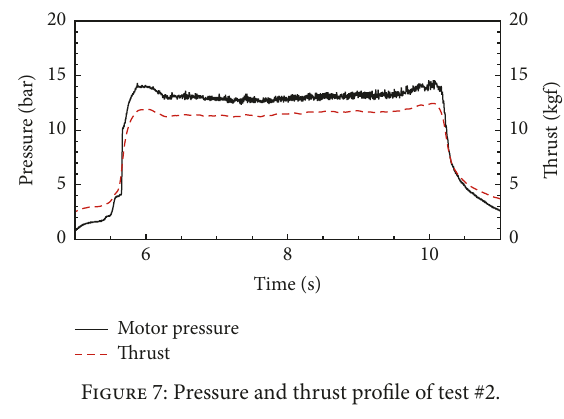
Figure 7: Pressure and thrust profile of test #2.